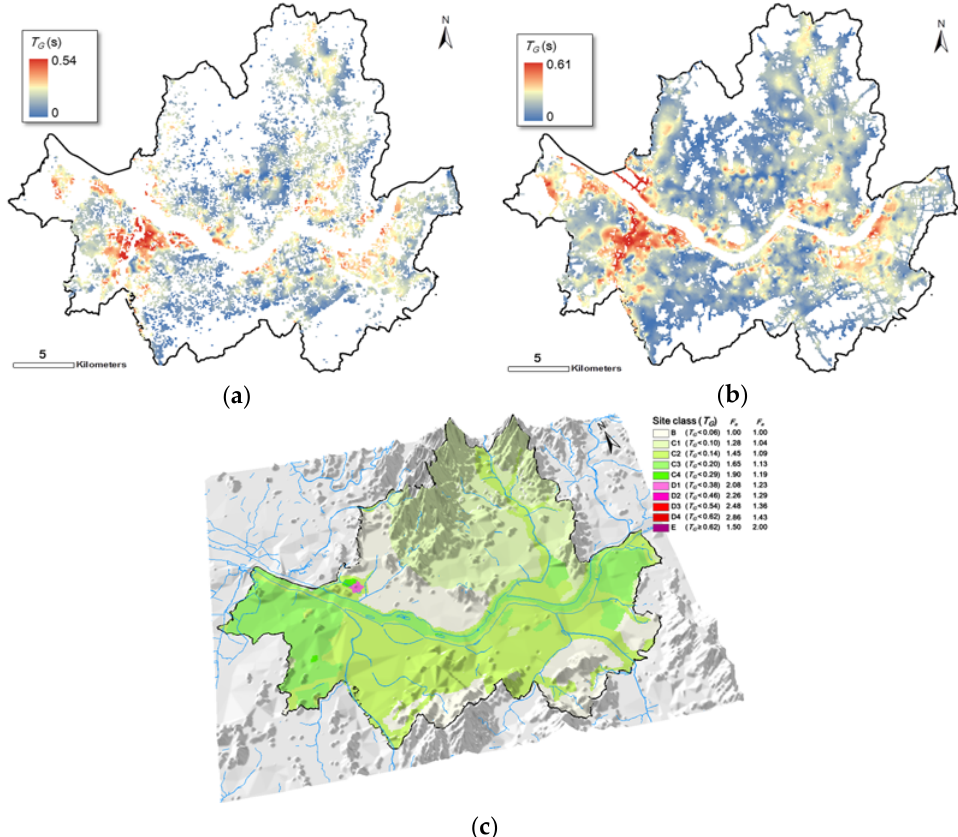
Figure 9. Geospatial zonation of site classes corresponding to T G , based on infrastructure and geological maps: ( a ) spatial distribution of T G under the building buffer zone ( b ) spatial distribution of T G over the pipeline buffer zone and ( c ) site classes based on geological boundaries.